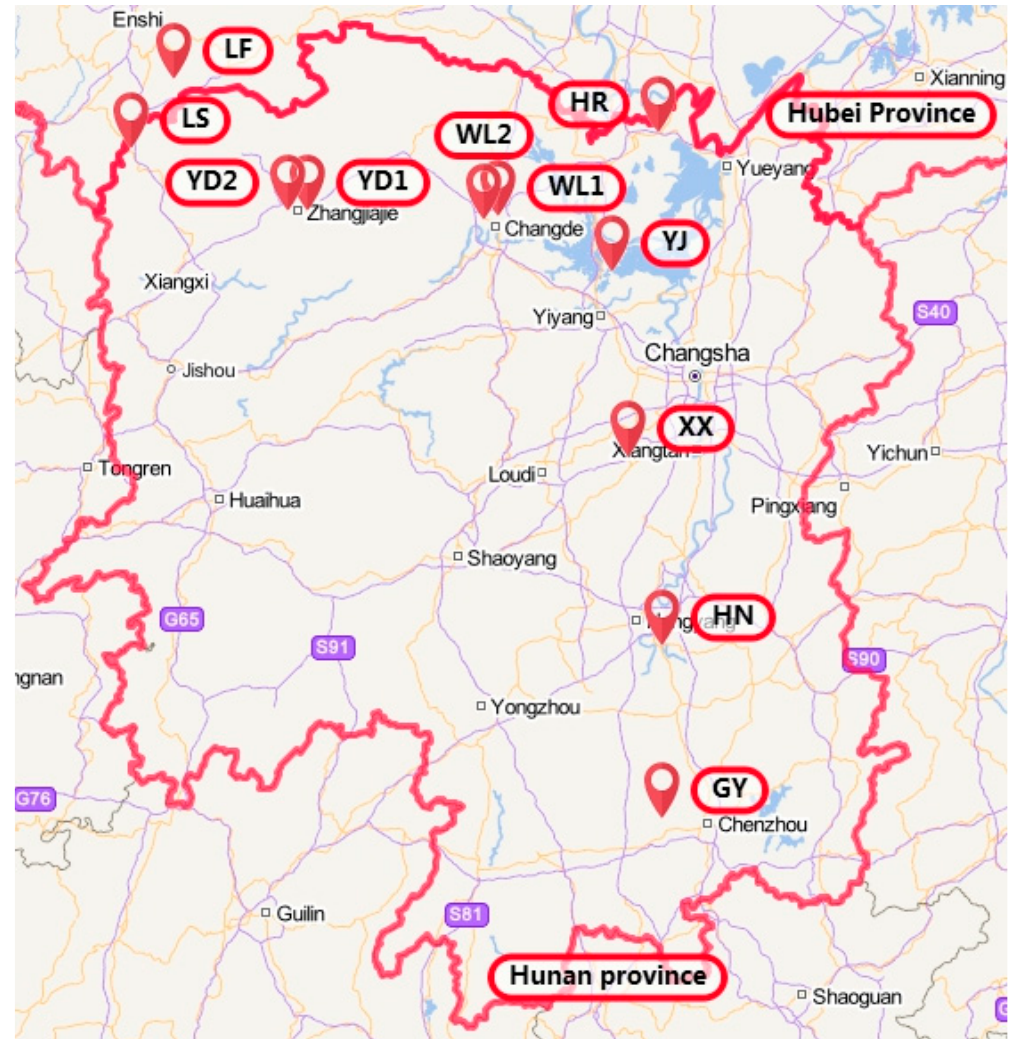
Figure 1. Geographical distribution of 11 strawberry root rot sampling. This figure was generated using the Landmap program (https://www.ldmap.net/index.html, accessed on 15 March 2022) with input of the geographic coordinates for the 11 sites. Table 1. Geographic information for the 11 sampling sites, sampling time, and abbreviated code for each. The sample sizes of F. commune strains obtained at the 11 sites are shown below and analyzed in the Results section.